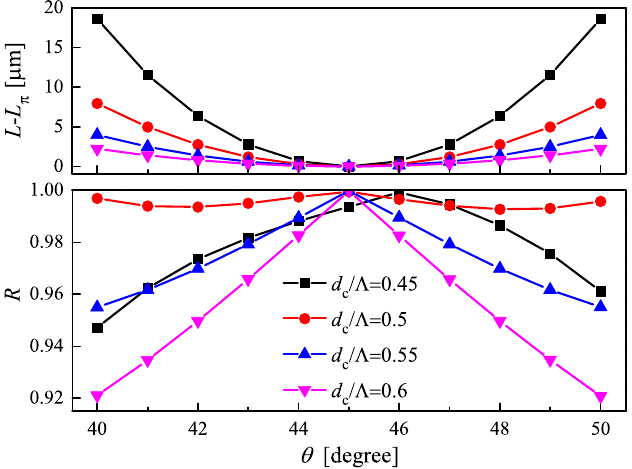
Figure 9. The variation of difference between a fixed device length and the corresponding conversion length ( L − L π ) and the modal hybrid ( R ) against the angle θ with different values at λ = 1.55 µ m.